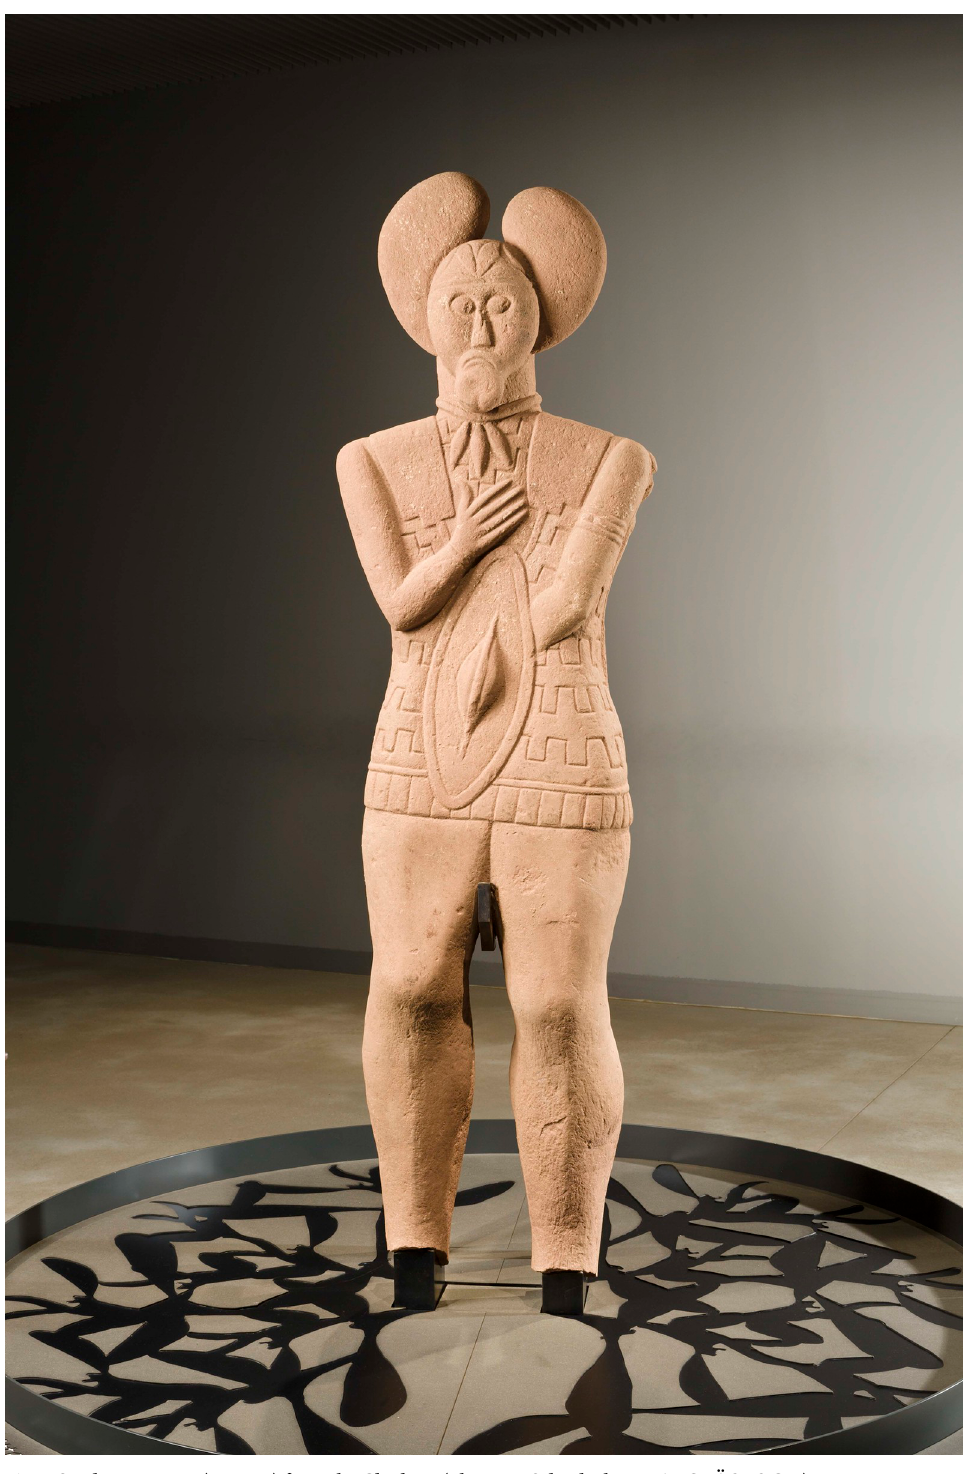
Fig 2. Sandstone statue (statue 1) from the Glauberg (photo: P. Odvody, hessenARCHA ¨ OLOGIE).